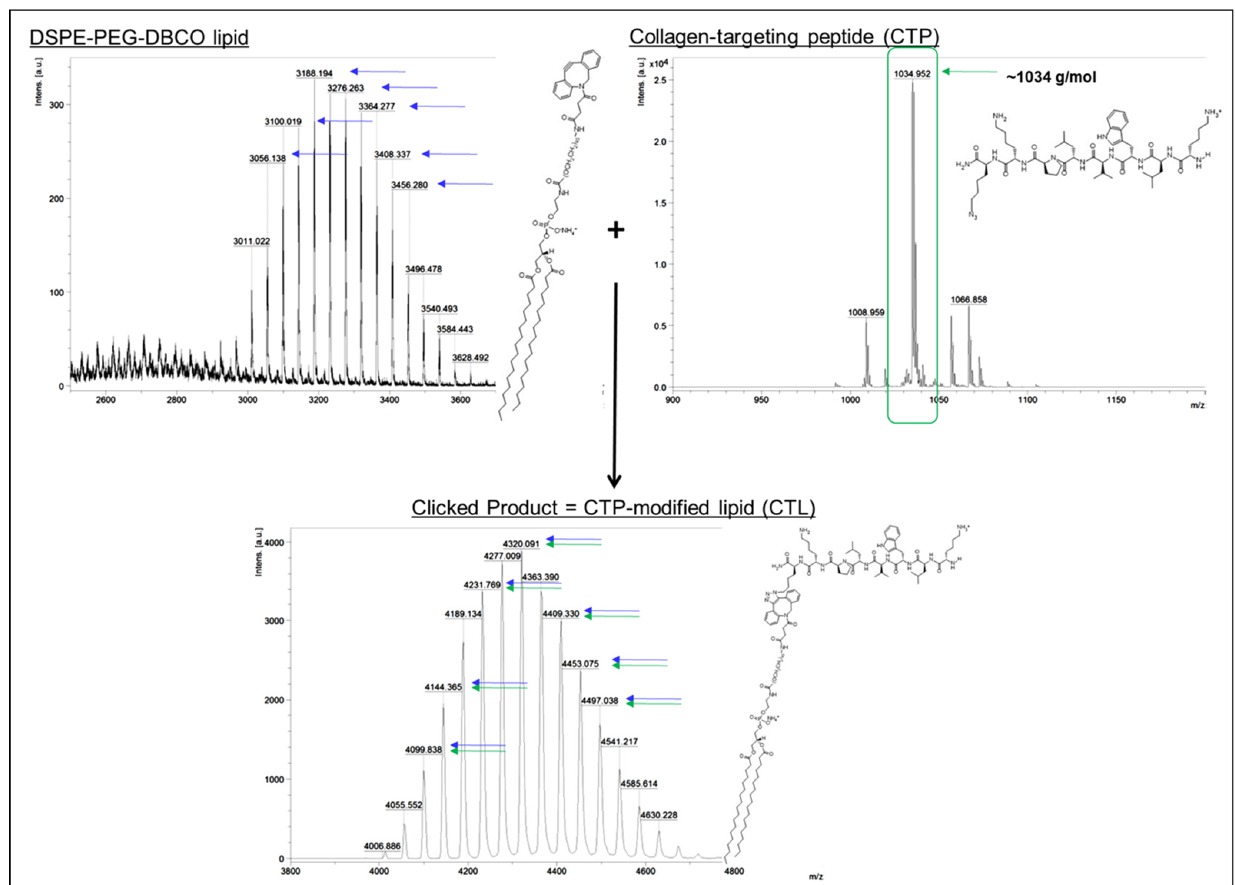
Figure 1. Spectra and structures of lipid/peptide constituents used for collagen-targeting peptide-modified lipid (CTL) conjugation. The mass spectrometry confirmed peptide conjugation, where peaks of aggregate molecular weight were demonstrated in the reaction product spectra, compared to peaks in the collagen-targeting peptide (CTP) spectra and pre-clicked DSPE-PEG-DBCO spectra alone .